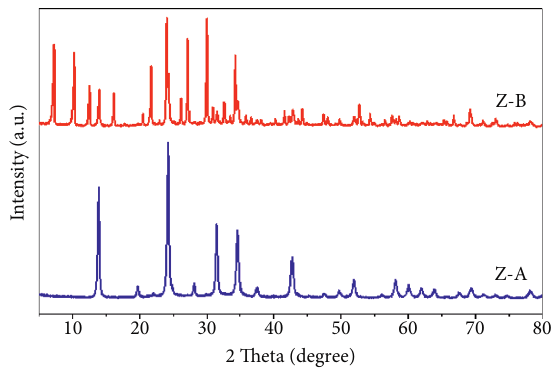
Figure 1: XRD patterns of Z-A and